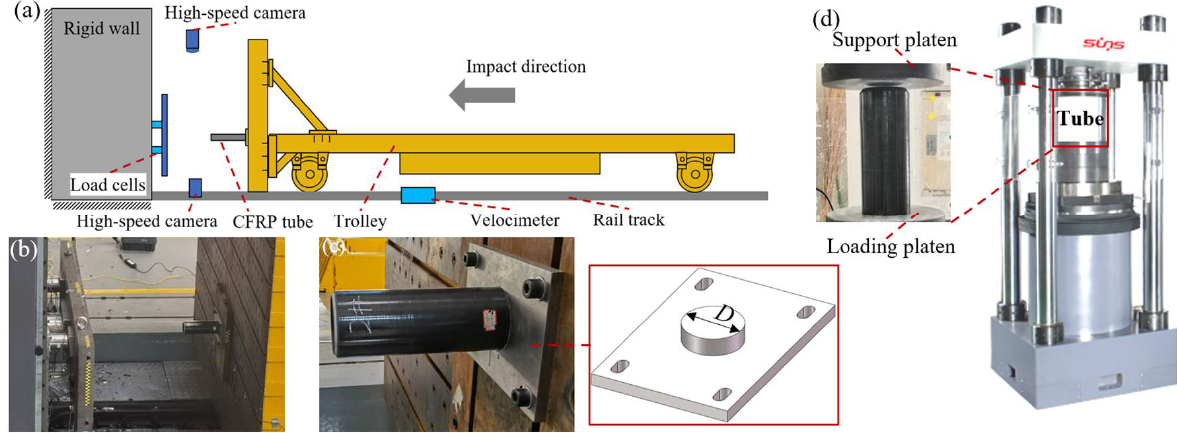
Figure 2. ( a ) Layout schematic, ( b ) collision zone, and ( c ) test trolley and specimen for dynamic impact test and ( d ) quasi-static test setup.